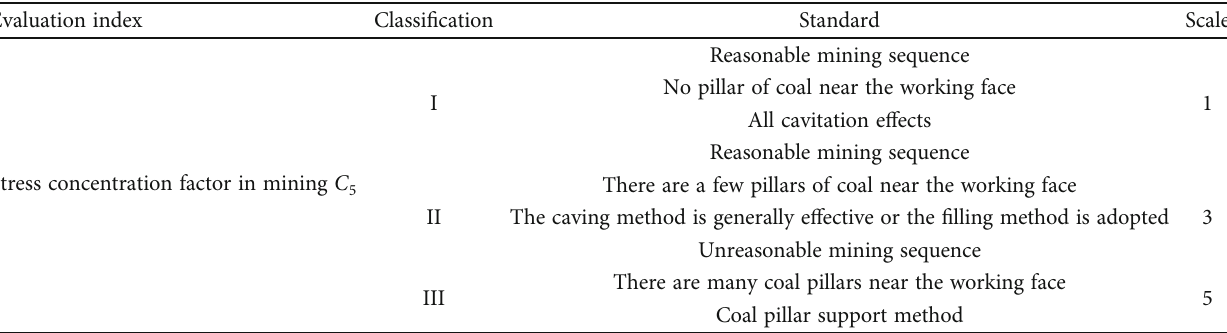
Table 8: Classi fi cation of mining stress concentration.